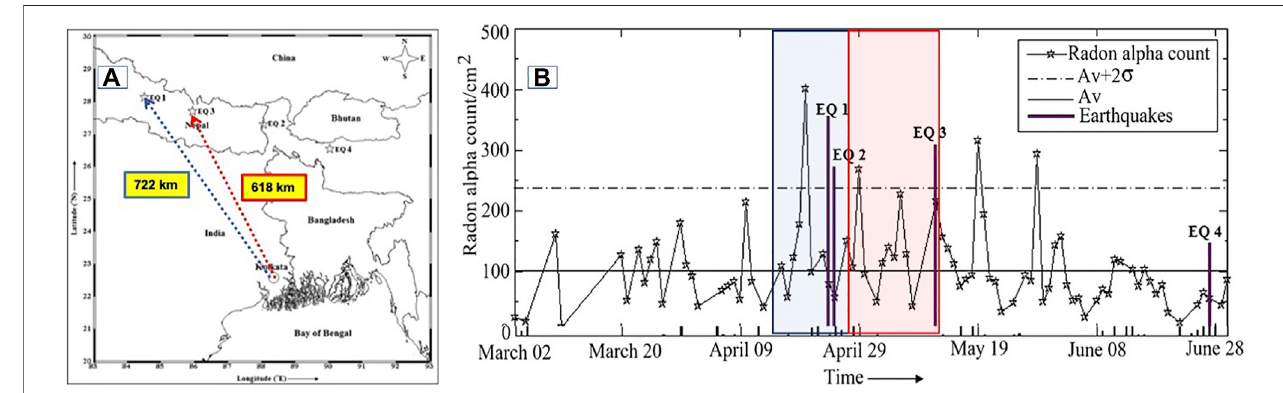
FIGURE3| Radon observation inKolkata, India (A) Map indicating themonitoring sitesinKolkata andtheMS+ earthquakeswithin1000kmregion. (B) Combined graph for radon-222 anomalies at location (A) and the corresponding earthquakes during the observation period from March 1 to June 30, 2015. EQ l -M7.8 of 04.25.2015; EQ2- M6.9 of 04.26.2015 and EQ3- M7.3 of OS.12.2015. (Deb at all,